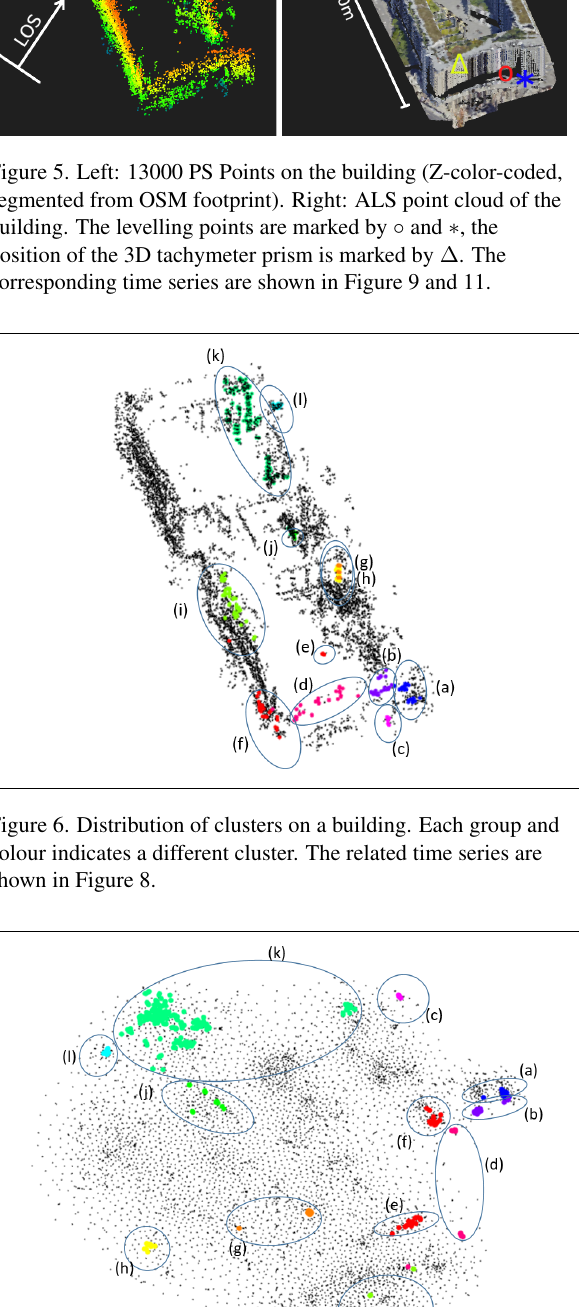
Figure 8. Center points of the clusters in Figure 6 as time series in colour, all members of the cluster in black. The temperature on the building is shown in the bottom plot. Plot (c) is compared to the precise levelling ground truth in Figure 9. Plot (d) is compared to the LOS projection of the 3D tachymeter in Figure